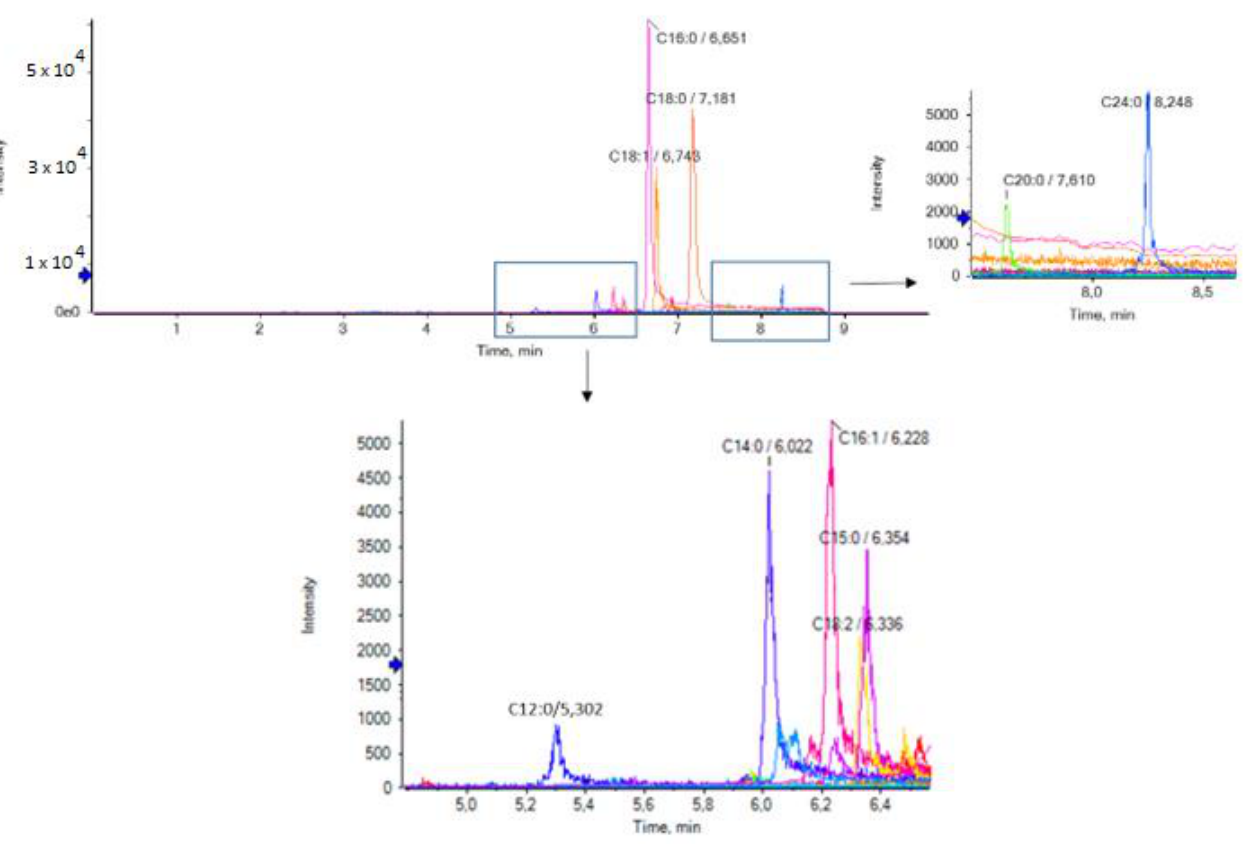
Figure 1. Extracted ion chromatograms (EICs) of the analytes in a representative RJ sample. Table 1. Contents of common long-chain FFAs in RJ samples (mg/100 g fresh